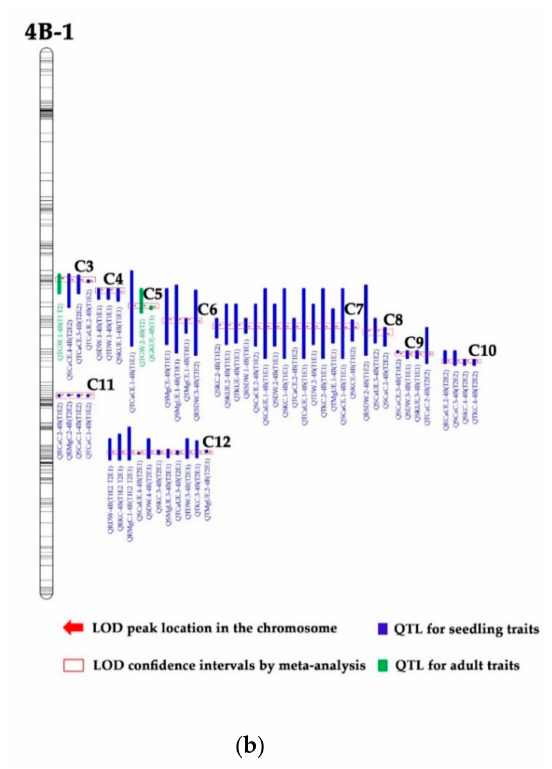
Figure 1. Locations of QTL clusters for wheat seedling and adult traits in di ff erent K treatment based on RILs derived from Tainong18 × Linmai6. In the names of the QTLs, E1 and E2 stand for the hydroponic trials of February 2013 and March 2013, respectively. T1 and T2 stand for the CK and LK treatments,